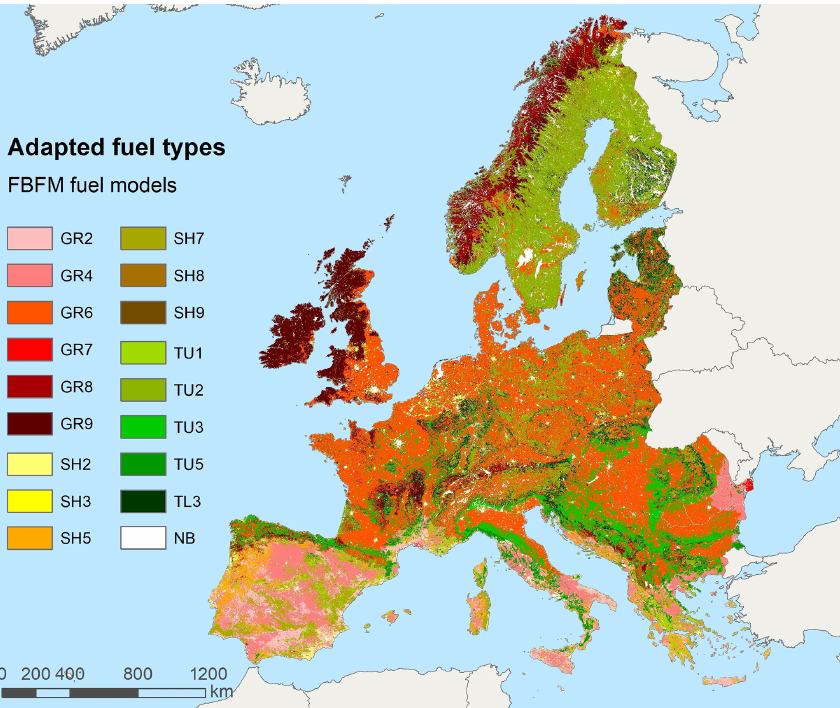
Figure 6. European fuel models based on the FBFM fuel models (Scott and Burgan, 2005) at 1km resolution. See Table C2 in Appendix C for the fuel descriptions and